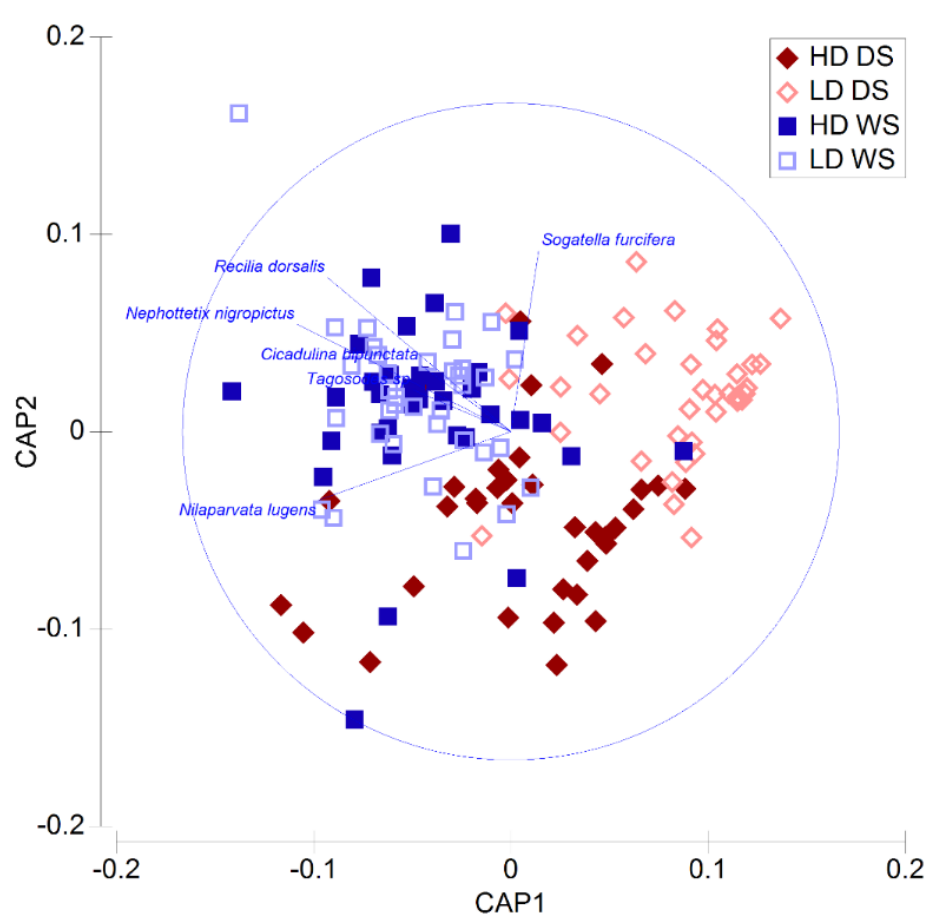
Figure 3. Canonical Analysis of Principal Coordinates (CAP) showing differences in herbivore (planthopper and leafhopper) species composition between blow-vac samples. Red colors indicate samples collected during the dry season (DS), whereas blue colors indicate samples collected during the wet season (WS). Filled and unfilled symbols represent high-density (HD) and low-density (LD) rice planting, respectively. Overlayed vectors (in blue) represent the correlations (Pearson’s correlation coefficient > 0.3) between herbivore species and the CAP axes, where vector length and direction reflect the increasing values of correlation and parameter values, respectively.